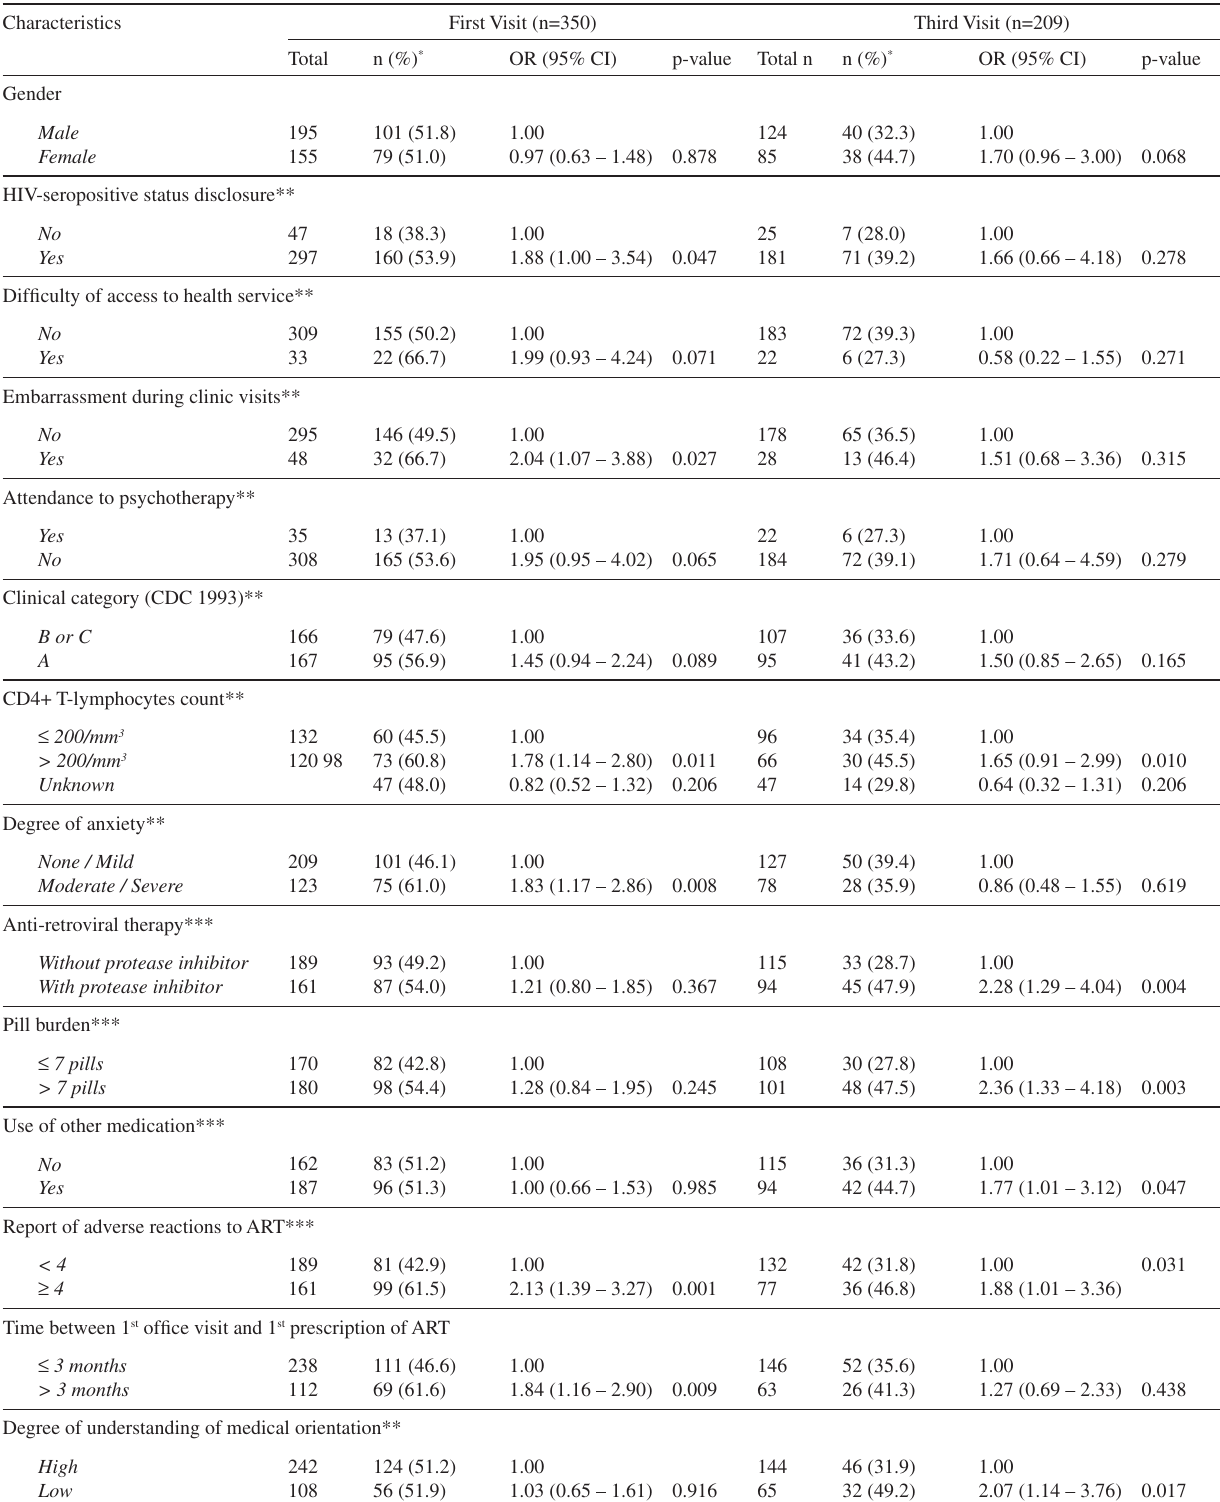
Table 3 - Univariate analysis of the degree of difficulty according to selected characteristics (p-value < .020) in the first and third visits, ATAR Project,